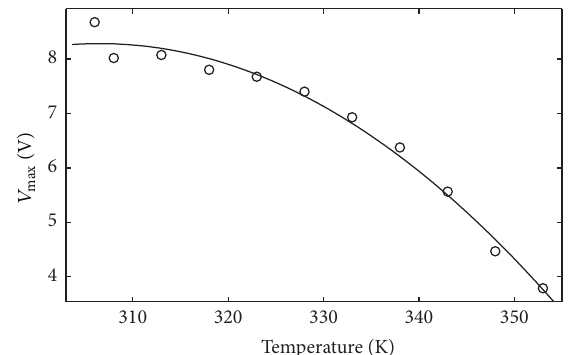
Figure 6: A sample curve showing the monotonously decreasing behavior of 𝑉 max with increasing temperature. The data were col- lected at constant frequency of 20Hz and bending radius of 12cm.